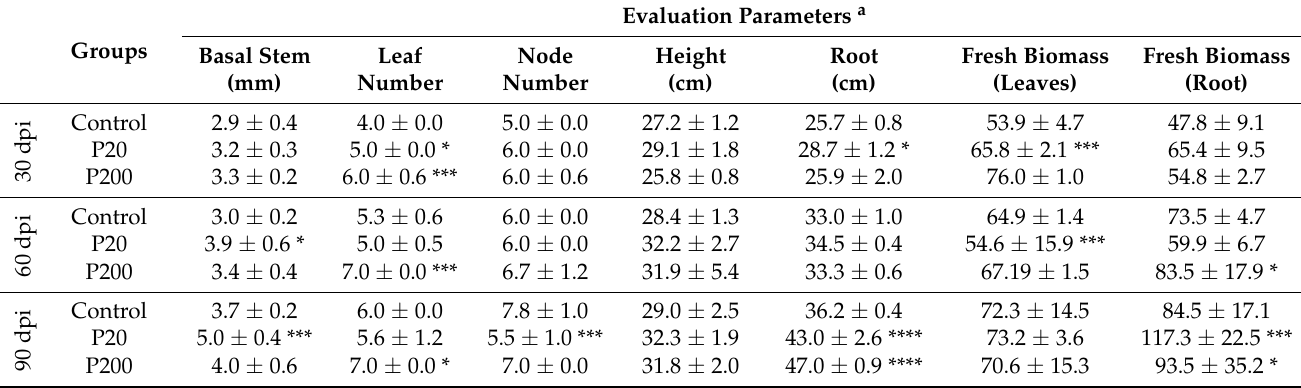
Table 1. Growth parameters of Piper divaricatum at different concentrations of